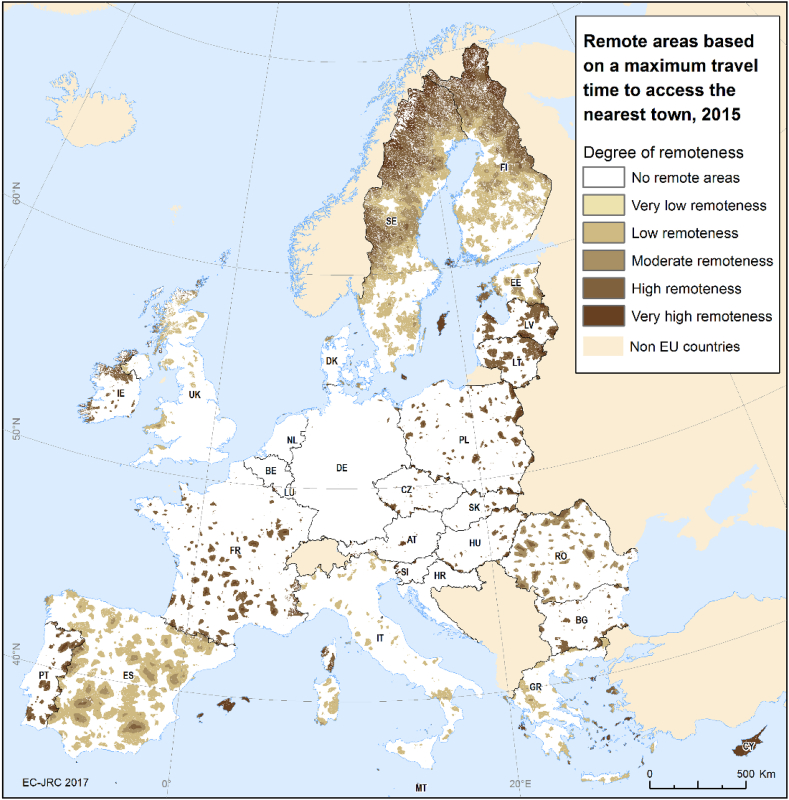
Map of remote areas computed at Member State level, adding also the UK, 2015.